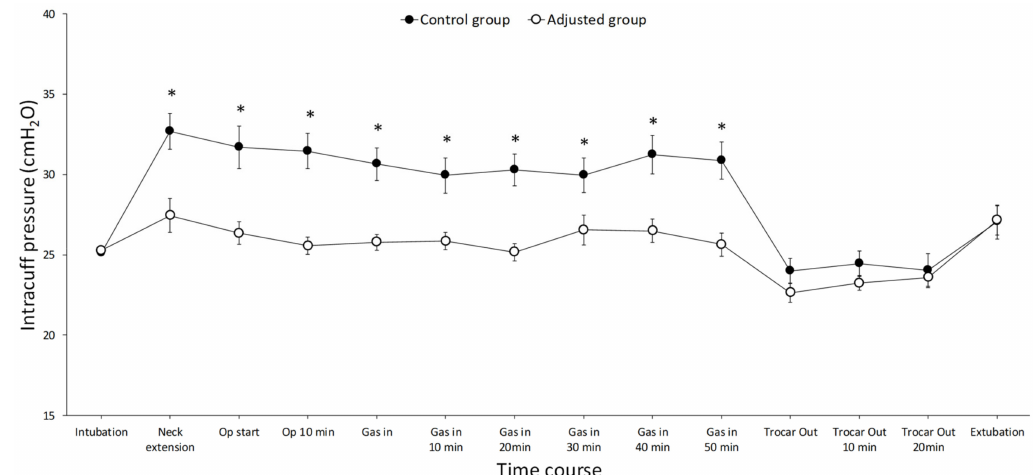
Figure 3. Changes in the cu ff pressure during scarless remote access endoscopic and robotic thyroidectomy. There was a significant di ff erence in the cu ff pressure over time between the two groups; the cu ff pressure was lower in the adjusted group than in the control group ( p < 0.001). The intragroup